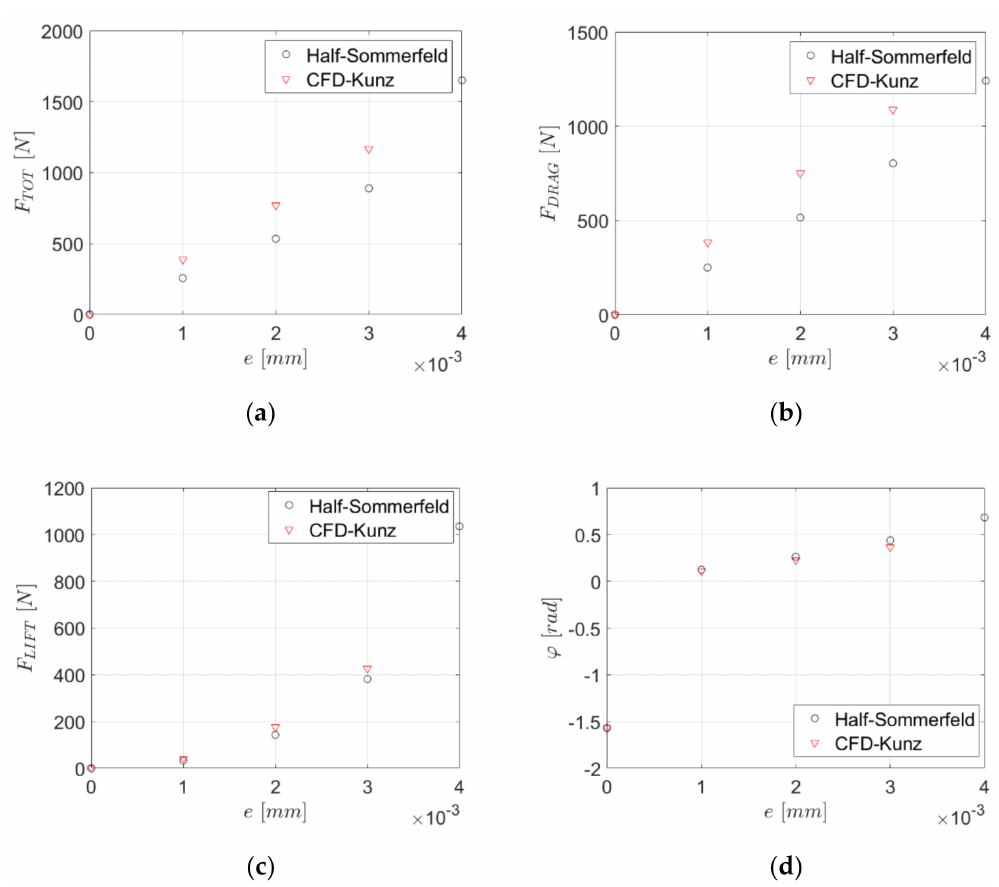
Figure 5. Total hydraulic force ( a ) Drag (F ⊥ ) force ( b ); Lift (F || ) force ( c ) and attitude angle ( d ) vs. eccentricity; –328 rad / s.